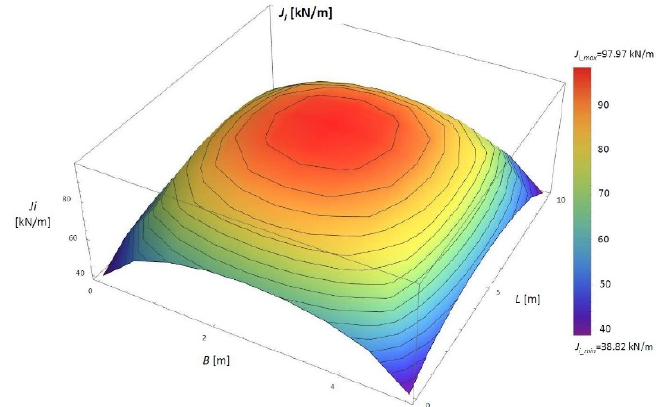
Figure 12. The values of the J i parameter in the 3D view for the numerical simulation. B , width of the embankment (m); L , length of the embankment (m).